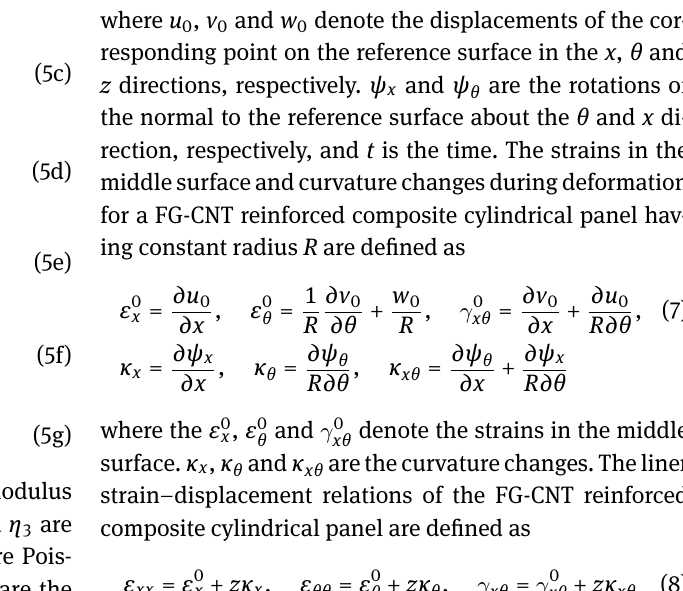
Figure 3: CNT distribution shape function of FG-CNT reinforced com- posite